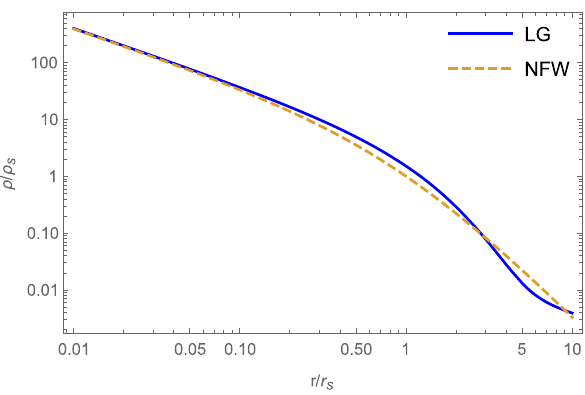
Figure 1: The density pro fi le of ( 17 ) compared with NFW. Eq. ( 17 ) satis fi es the conditions with the central density ρ ρ 0 0 total mass M M LG NFW = , and the radius R R r 9 s LG NFW = = where r s is the scale radius in the NFW pro fi